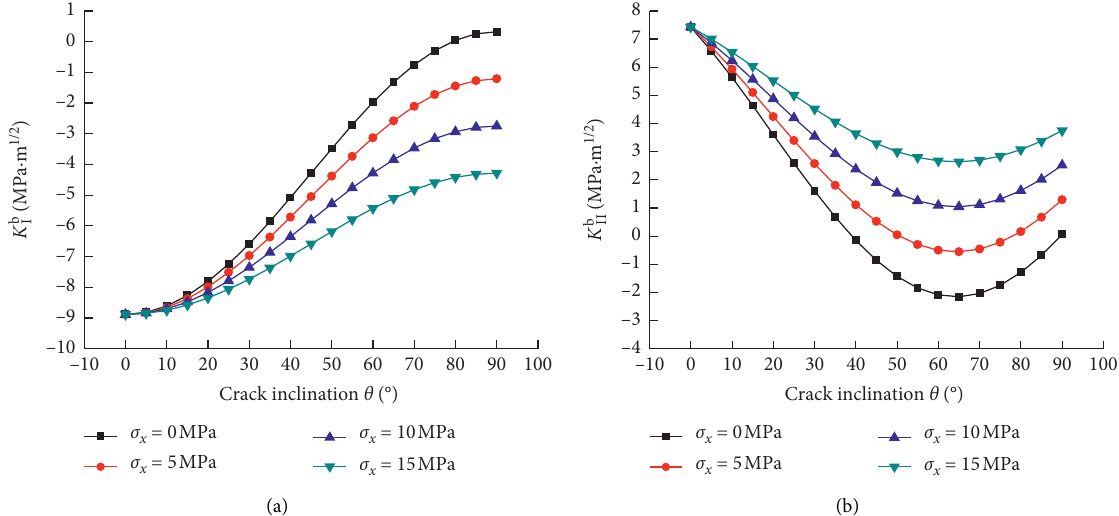
Figure 7: Relationship between crack inclination and stress intensity factor at different lateral pressures of closed crack ( f � 0.8, P (a) Mode I. (b) Mode II.